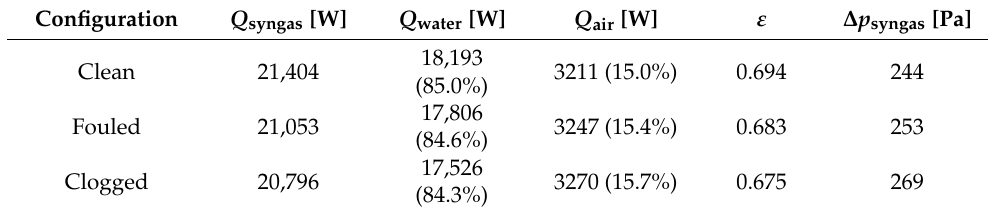
Table 5. Heat exchanger performance for the considered